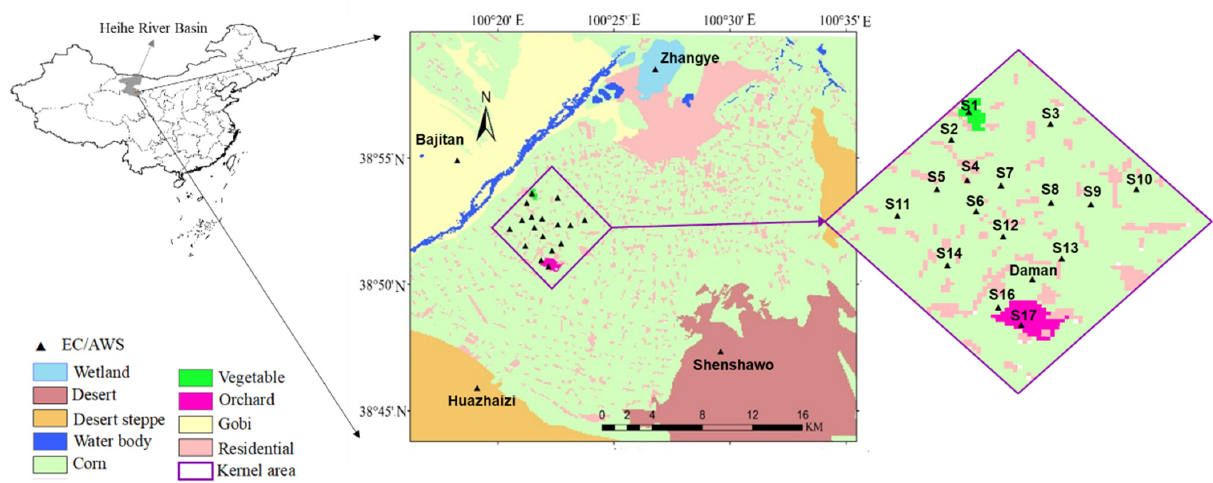
Figure 1. The distribution of 21 observation sites and the land use classifications over two nested experimental areas along the middle reaches of Heihe River Basin (HRB) in northwestern China. The 30 × 30 km experimental area is bounded by black lines, and the 5.5 × 5.5 km kernel experimental area is bounded by purple lines. The site names and descriptions are provided in Table 1. Table 1. Information about the stations in the middle reaches of HRB.